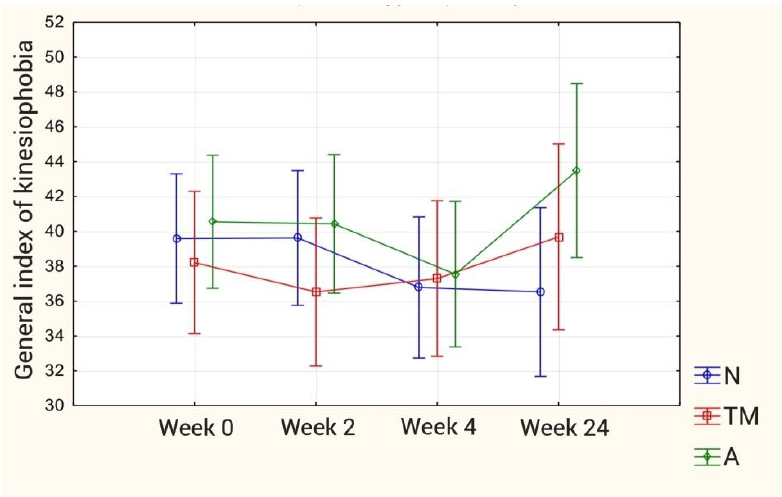
Figure 9. Mean values of the General Index of Kinesiophobia in individual groups. Table 2. Therapeutic effect in relation to the KCS questionnaire.